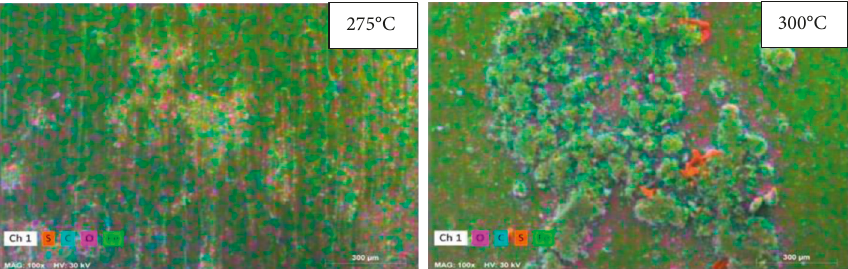
Figure 9: Elemental mapping on coupon surface with hard deposits at 275 and 300 ° C. Table 5: Effect of temperature on the formation of hard and soft deposits.